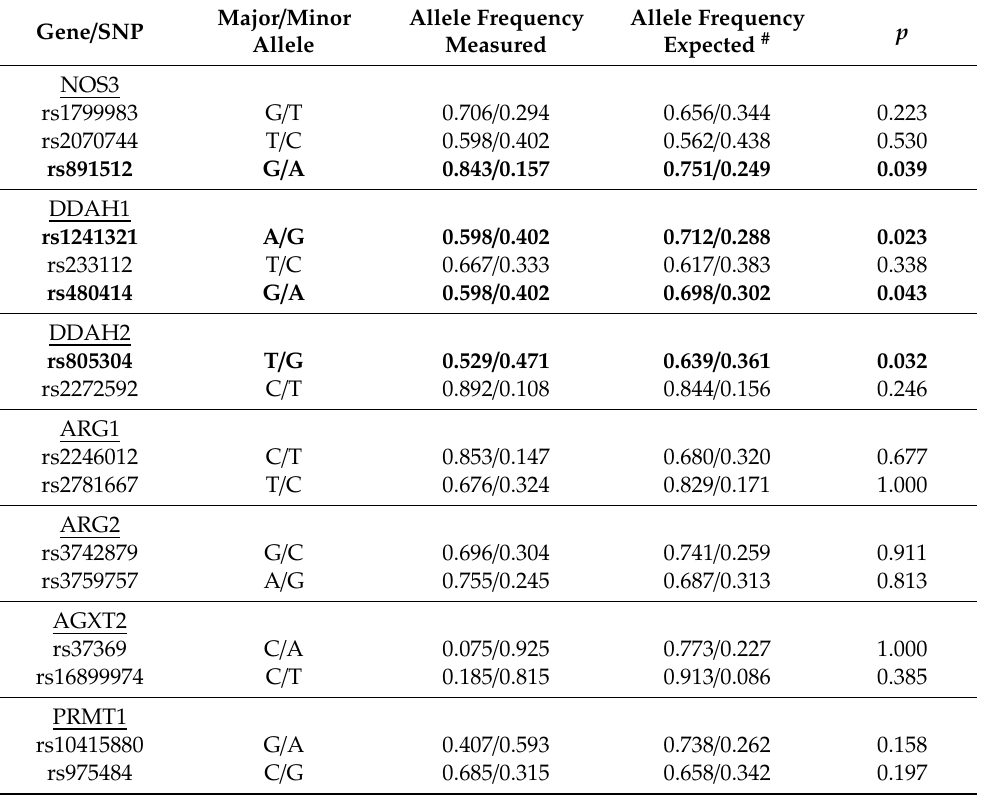
Table A2. Allele frequencies of studied